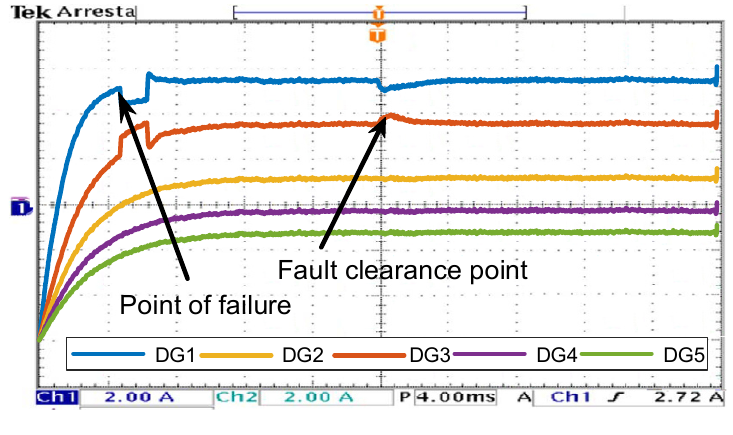
failureFault clearance point Point of